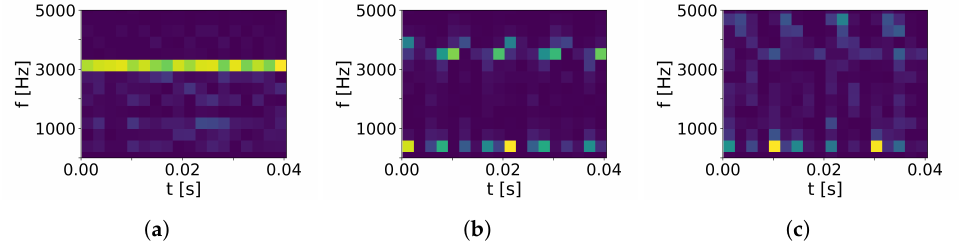
Figure 9. Frequency spectrograms taken at location F w (see Figure 8) during four actuation cycles, for a pulsating base bleed of f = 100 Hz and different non-dimensional base bleed rates. ( a ) C b = 0.00. ( b ) C b = 0.13. ( c ) C b =